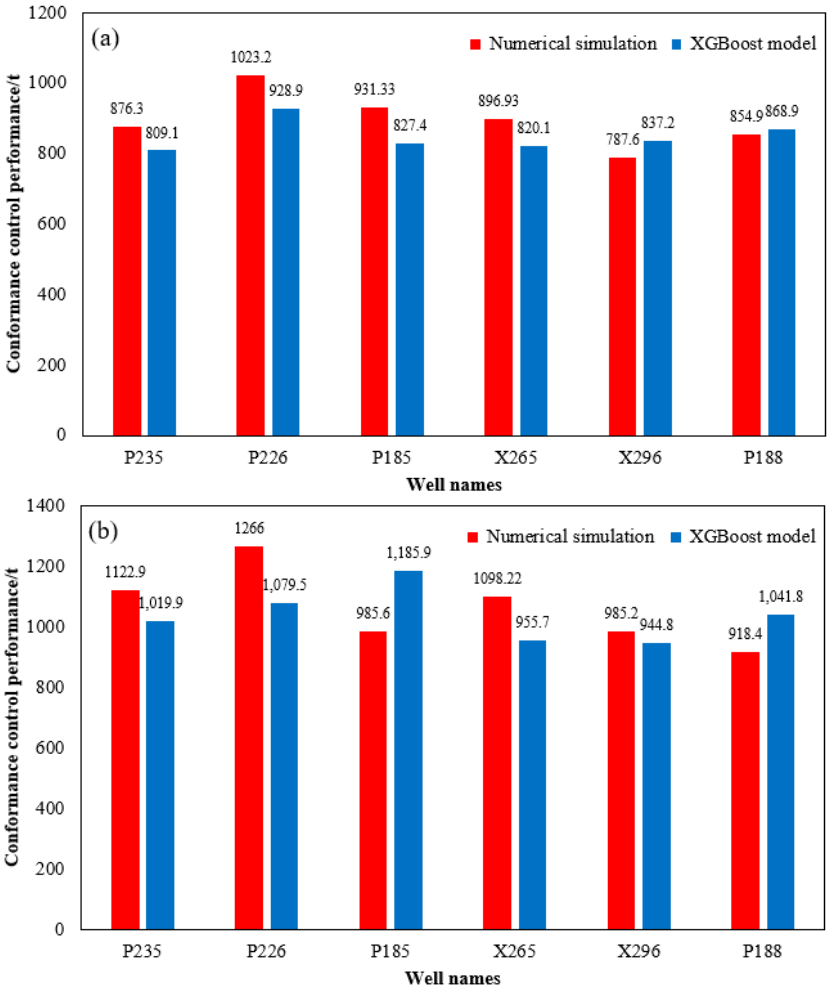
Figure 9. Comparisons of prediction results for profile control potential using the numerical simulation and XGBoost prediction model. ( a ) Potential of N 2 ‐ foam profile control. ( b ) Potential of gel profile control.